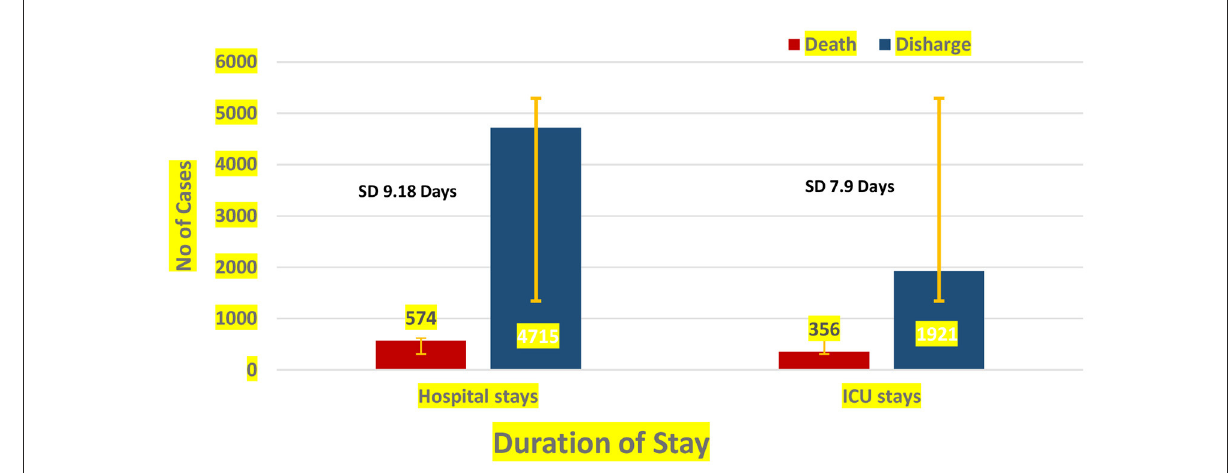
FIGURE2 Hospital and ICU stay among discharged and non-surviving of hospitalized patients diagnosed with COVID-19.